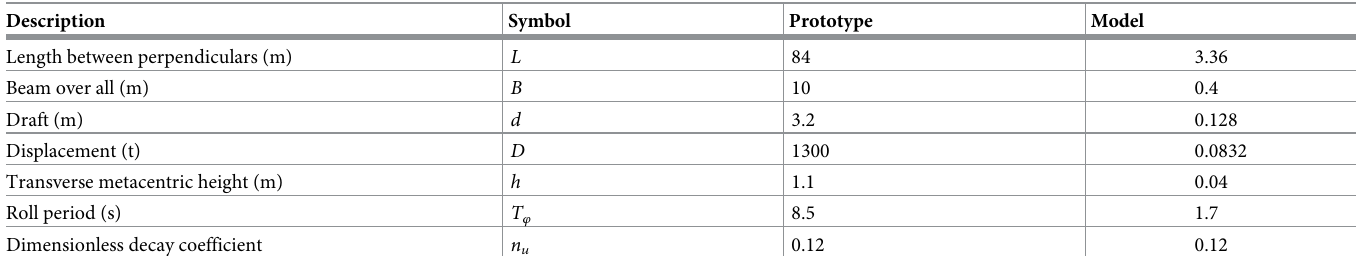
Table 1. Main parameters of the ship.